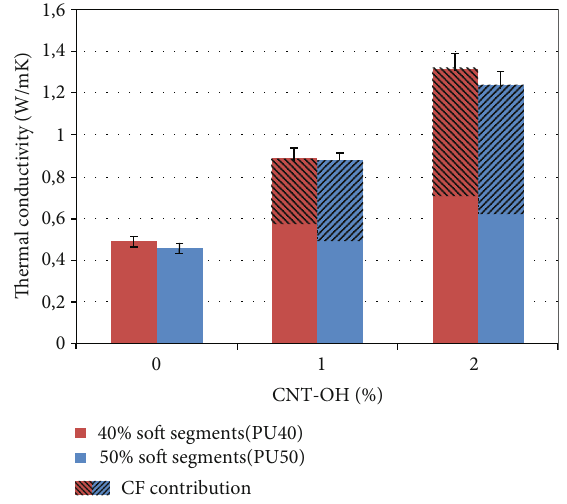
Figure 5: Thermal conductivity of neat PU and modi fi ed with CNT-OH and